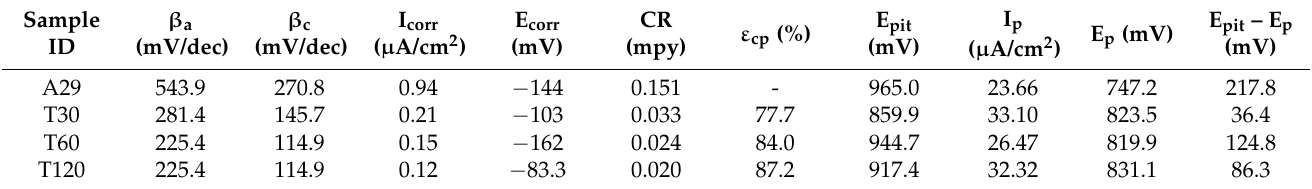
Table 5. The Tafel extrapolated data and pitting parameters obtained from the CPDP measurement for the samples heat-treated at different solutionizing durations.